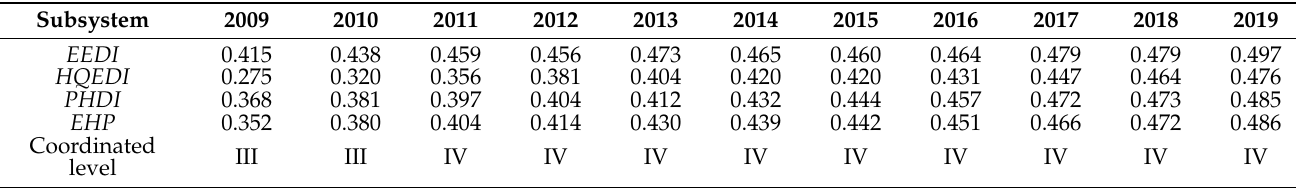
Table 4. The overall coordinated development index from 2009 to